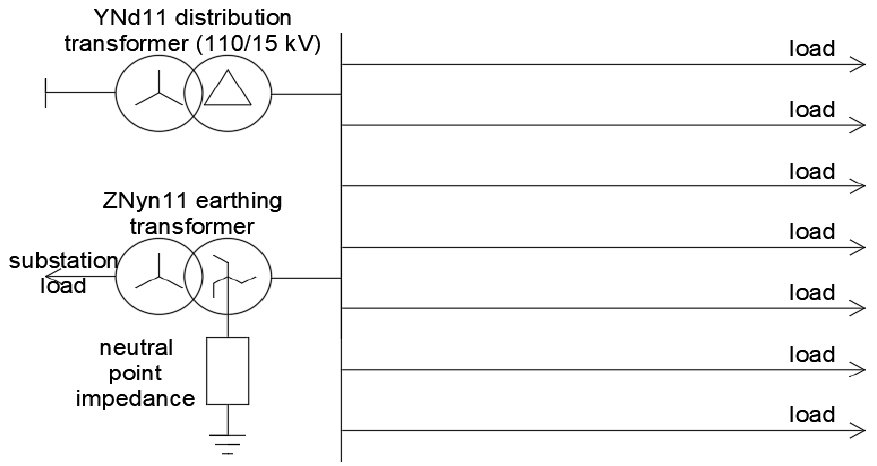
Figure 5. Typical distribution system network in Poland.